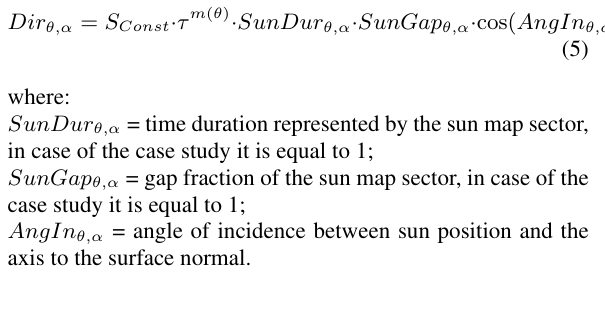
Figure 3. TIN and buildings (1.5x exaggeration, green arrow =